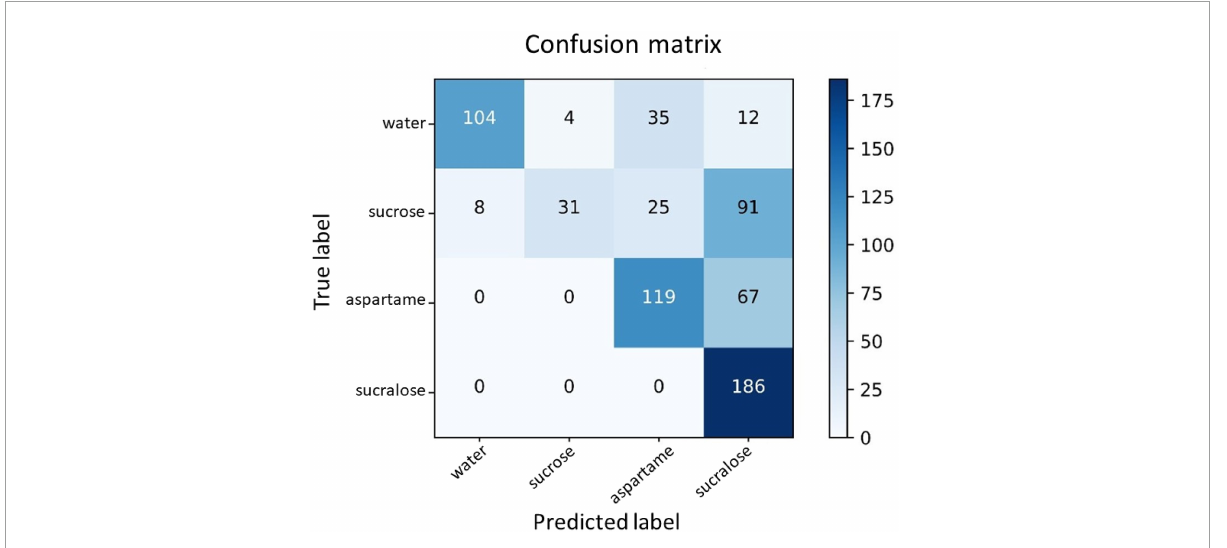
FIGURE4 Confusion matrix for the classes water, sucrose, sucralose, and aspartame. The horizontal axis is the predicted label, and the vertical axis is the true label. The elements on the diagonal represent the numbers of correctly classified samples.